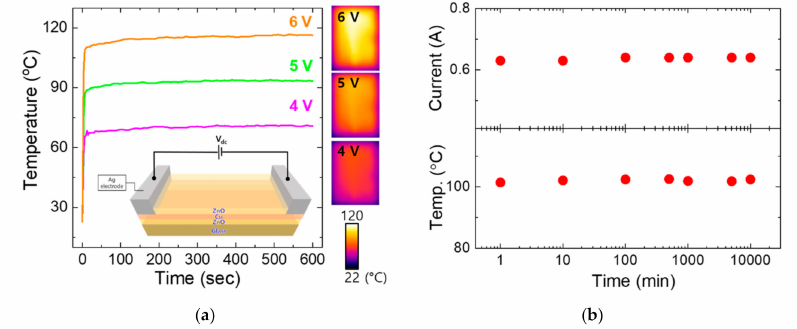
Figure 5. ( a ) Temperature profiles for the ZnO / Cu / ZnO electrodes in response to given external DC voltages, and the IR images corresponding to the applied voltages are also given. The schematic electrical setup was given as an inset. ( b ) Current (upper panel) and temperature (lower panel) as a function of time while the electrode temperature was maintained at ~100 ◦